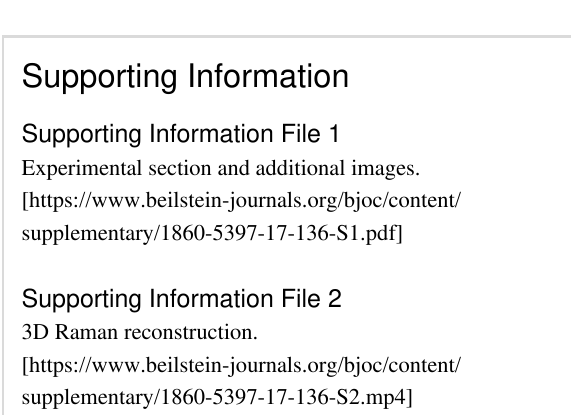
Figure 3: A) SEM image of pristine, uncoated PCL MEW scaffolds with a hatch spacing of 150 µm × 200 µm and inset (B), where the white arrows show embossing of the first printed layer on the bottom of the scaffold. C) PHEMA coated scaffolds (prominent spots of PHEMA coating marked with red arrows) of the same hatch spacing, irradiated from a distance of 1 cm for 30 min with a wavelength of 365 nm with inset shown in (D), where the yellow arrows point at PHEMA strands, in contrast to the irregularities caused by the printing (orange arrows). E and F) SEM images of scaffolds with a hatch spacing of 500 µm under the same conditions as C). The yellow arrow in (E) points at a border line of PHEMA and the red arrow in (F) at pure PHEMA in between fibers. G) SEM image of a scaffold with a hatch spacing of 500 µm under the same conditions as C), but freeze dried, with inset shown in (H), where the yellow arrows point at irregularities within the PHEMA coating. False colored blue for G and H indicates the exposed PCL fibers in the PHEMA-filled MEW scaffolds.